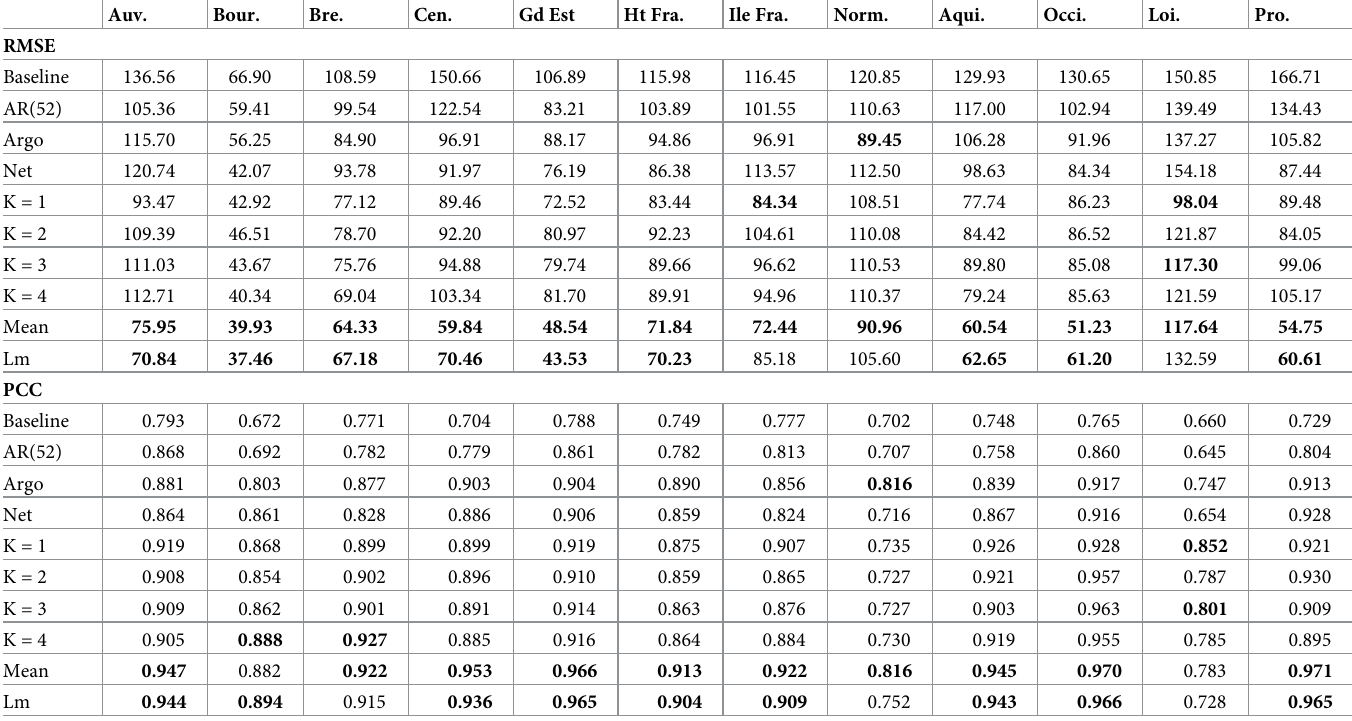
Table 12. PCC and RMSE for one-week ahead estimate for all french regions for the period starting from January 2015 to March 2017. Auv. Bour.